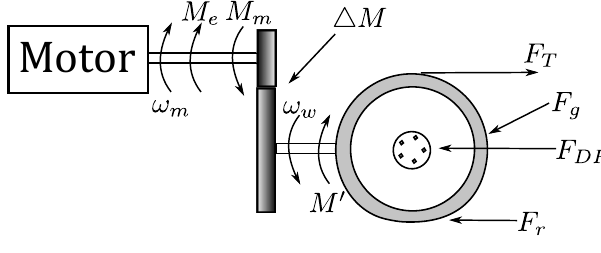
Figure 4. Simplified